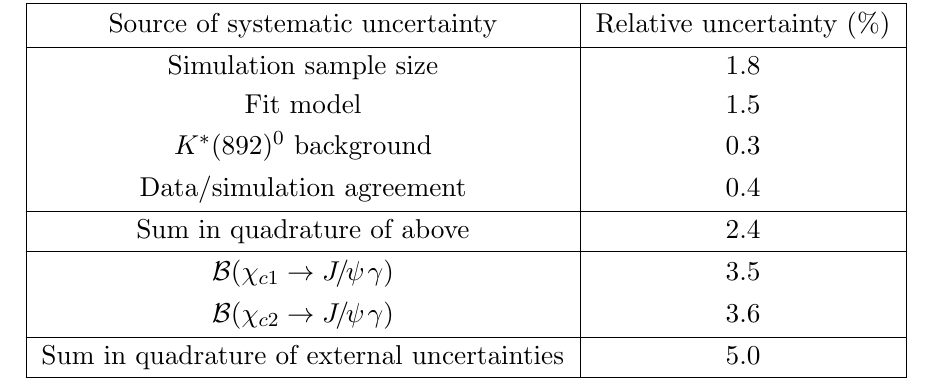
+ K ! (cid:31) B ( B 0 ! (cid:0) ) = c 2 K s s